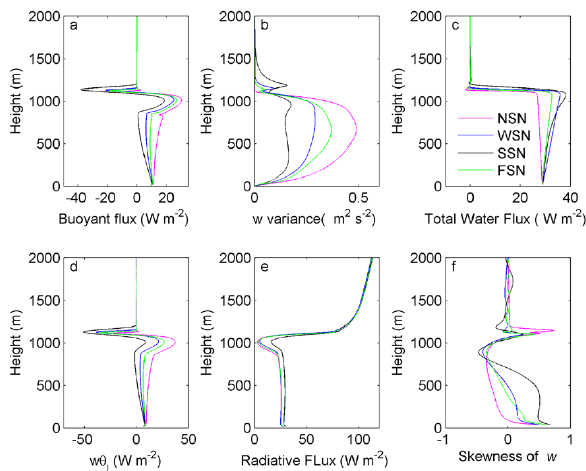
Fig. 9. Profiles of turbulence variables for four no-solar simulations. (a) C p ρ 0 w 0 θ 0 v ; (b) w 0 2 ; (c) Lρ 0 w 0 q 0 t ; (d) C p ρ 0 w 0 θ 0 ; (e) Longwave radiative flux; and (f) skewness of w , defined by w 0 3 /σ 3 / 2 w where σ w is the standard deviation of w